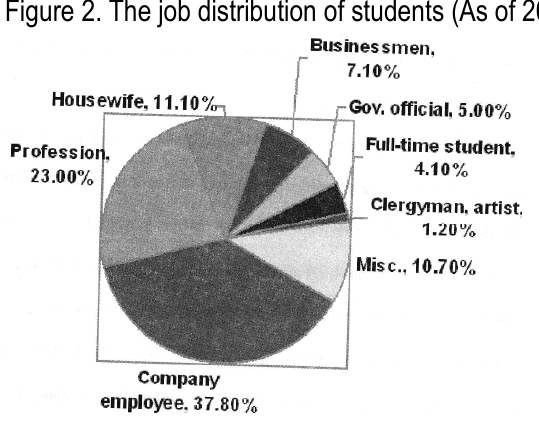
Figure 2. The job distribution of students (As of